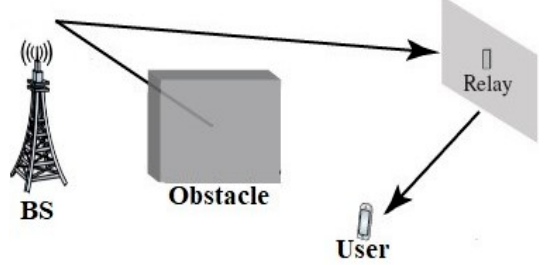
Figure 2. Relay-assisted transmission.